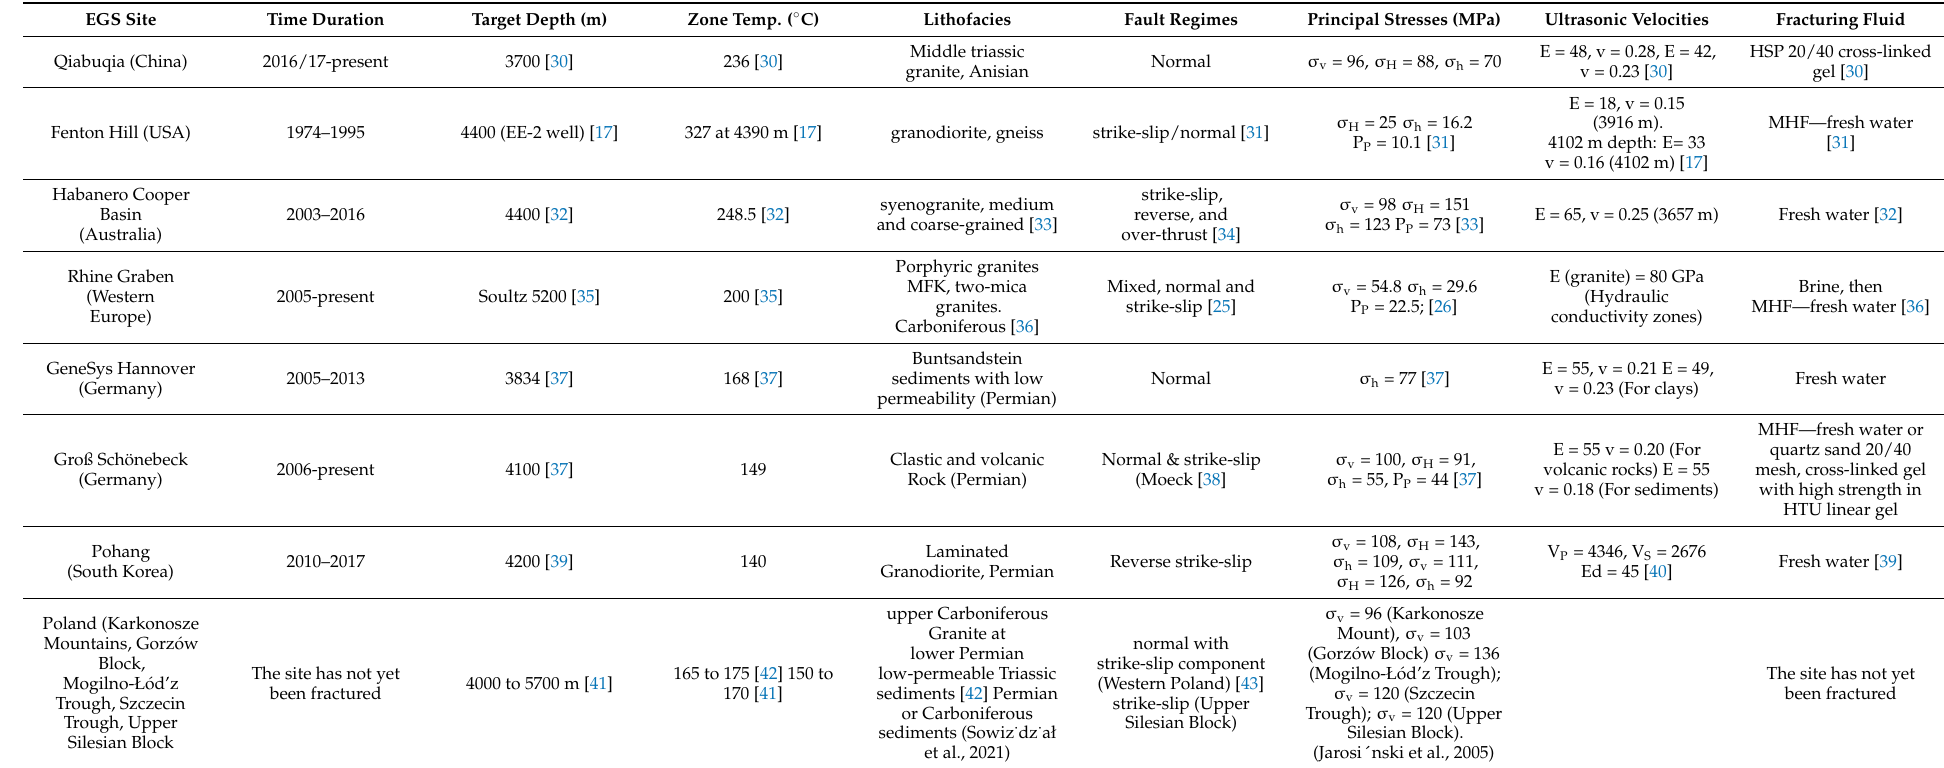
Table 1. Data compilation from EGS sites related to geology, tectonics, and fracturing. Where VP and VS = compressional or P- and shear or S-wave velocities in m/s, E = Young’s modulus (GPa), v = Poisson’s ratio, σ v = Vertical stress, σ h = Minimum horizontal stress (MPa), σ H = Maximum horizontal stress (MPa), PP = Pore pressure